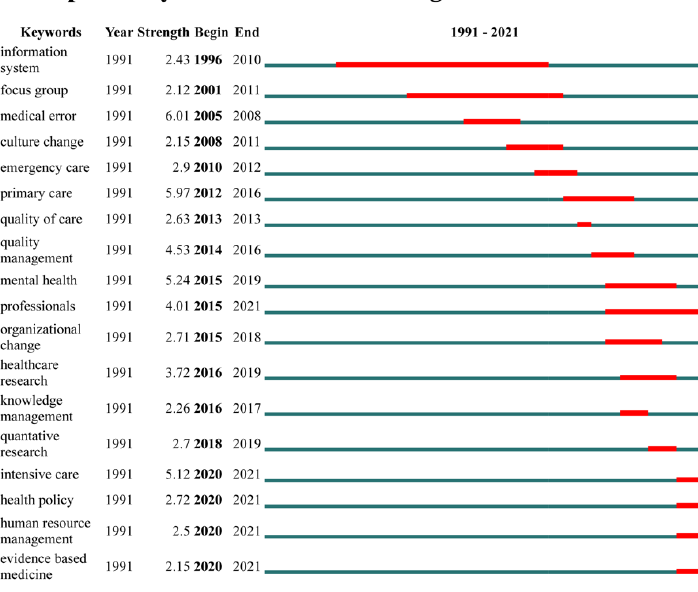
Figure 6. Temporal bar graph for burst terms.